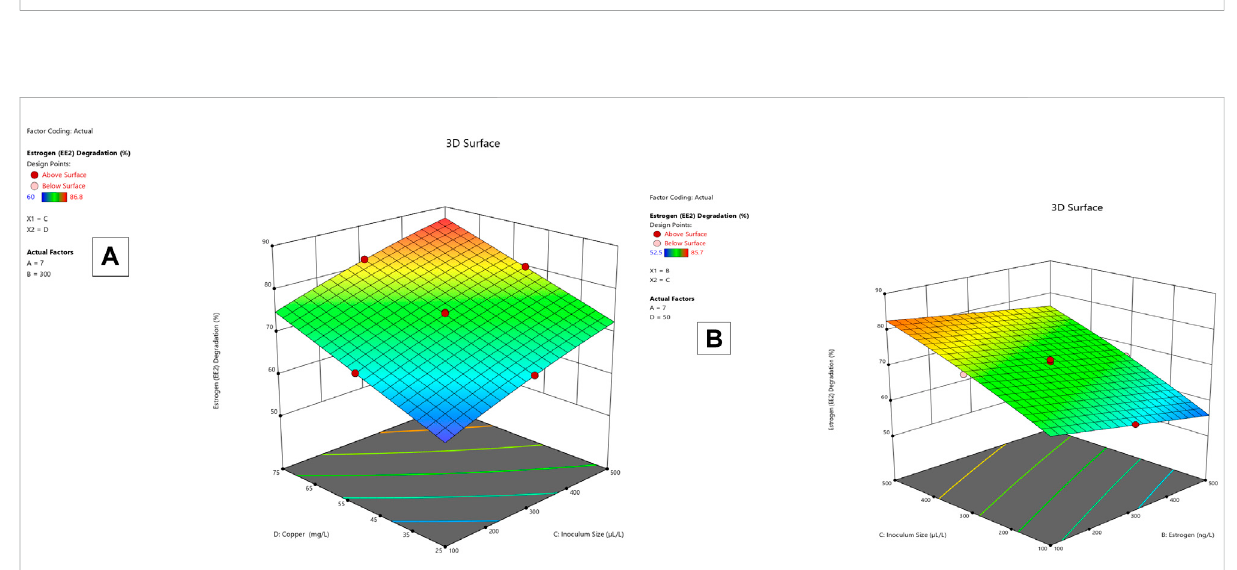
FIGURE 4 EE2 degradation 3D mesh diagram for Lysinibacillus. BP1 (A) and Lysinibacillus. BP2 (B)